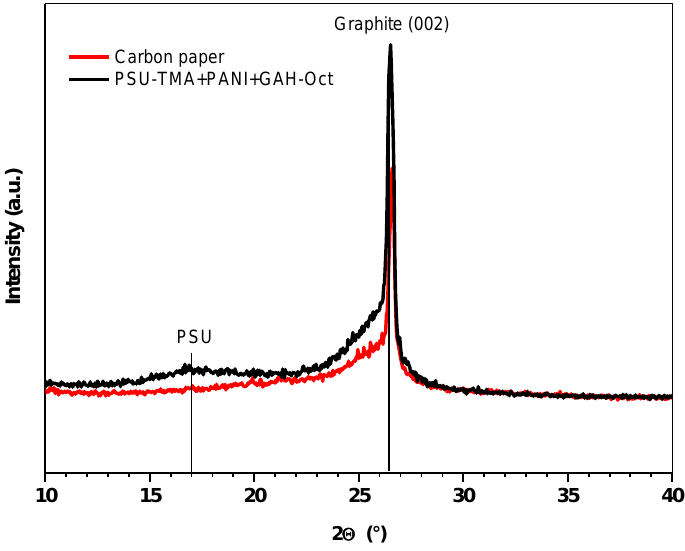
Figure 1. XRD patterns of carbon paper and PSU-TMA + PANI + GAH-Oct electrode.